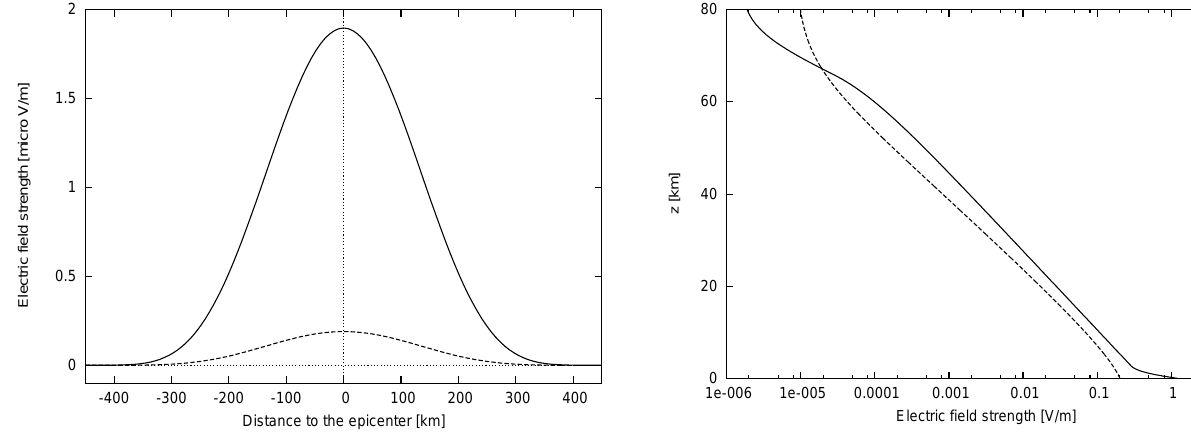
Fig. 6. Height distributions of the maximum values for the horizon- tal electric field E x ( 0 ,z) in this model (solid line) and E x (a,z) in the model of Denisenko et al. (2008) (dashed